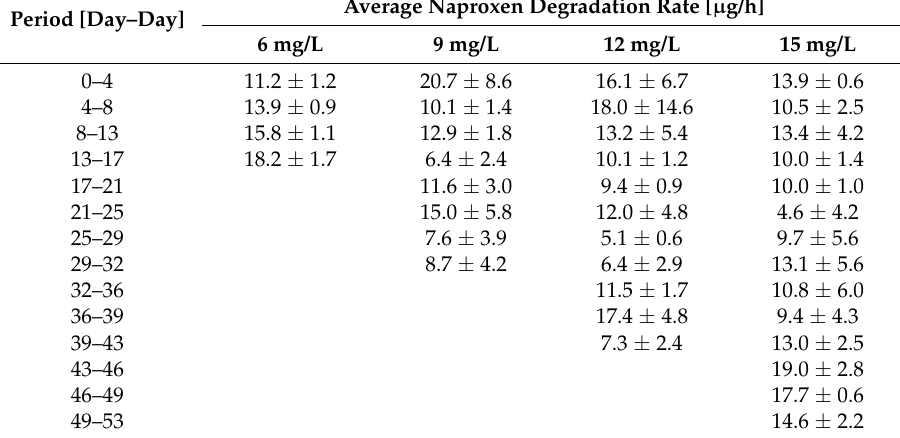
Table 2. Average naproxen degradation rates by immobilized cells of Planococcus sp. S5. Data presented as a mean ± standard deviation of three